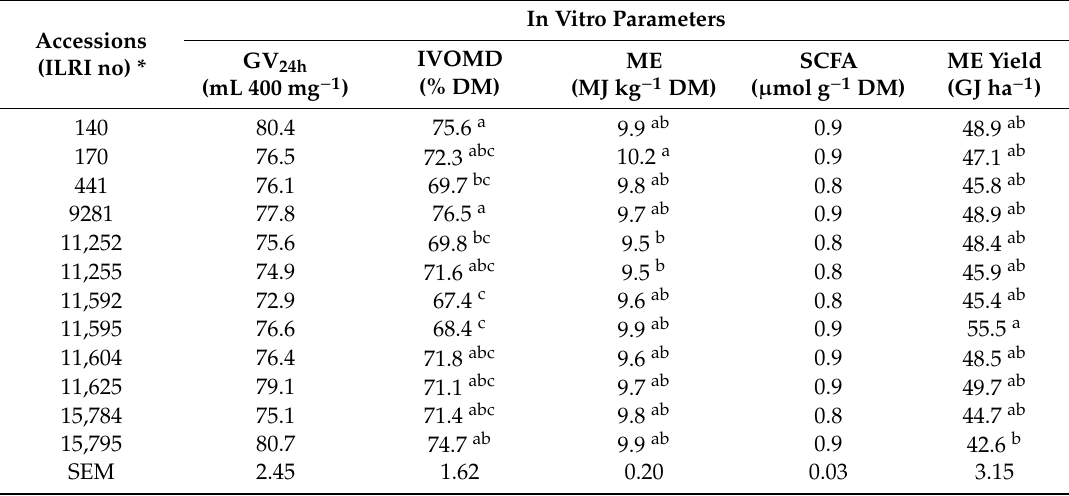
Table 7. Gas production, in vitro organic matter digestibility, metabolizable energy, short chain fatty acid and metabolizable energy yield for di ff erent forages of S. scabra accessions adapted in climatic condition of